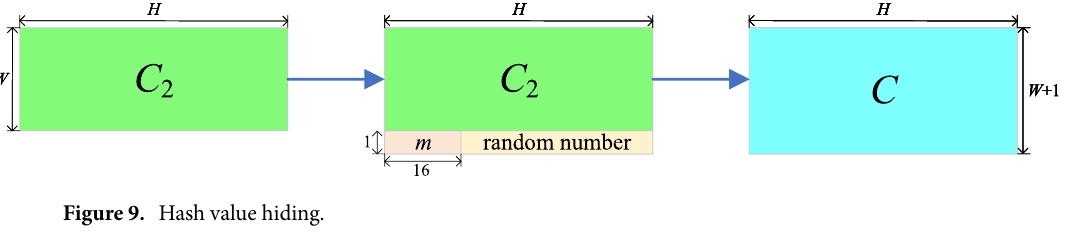
Figure 9. Hash value